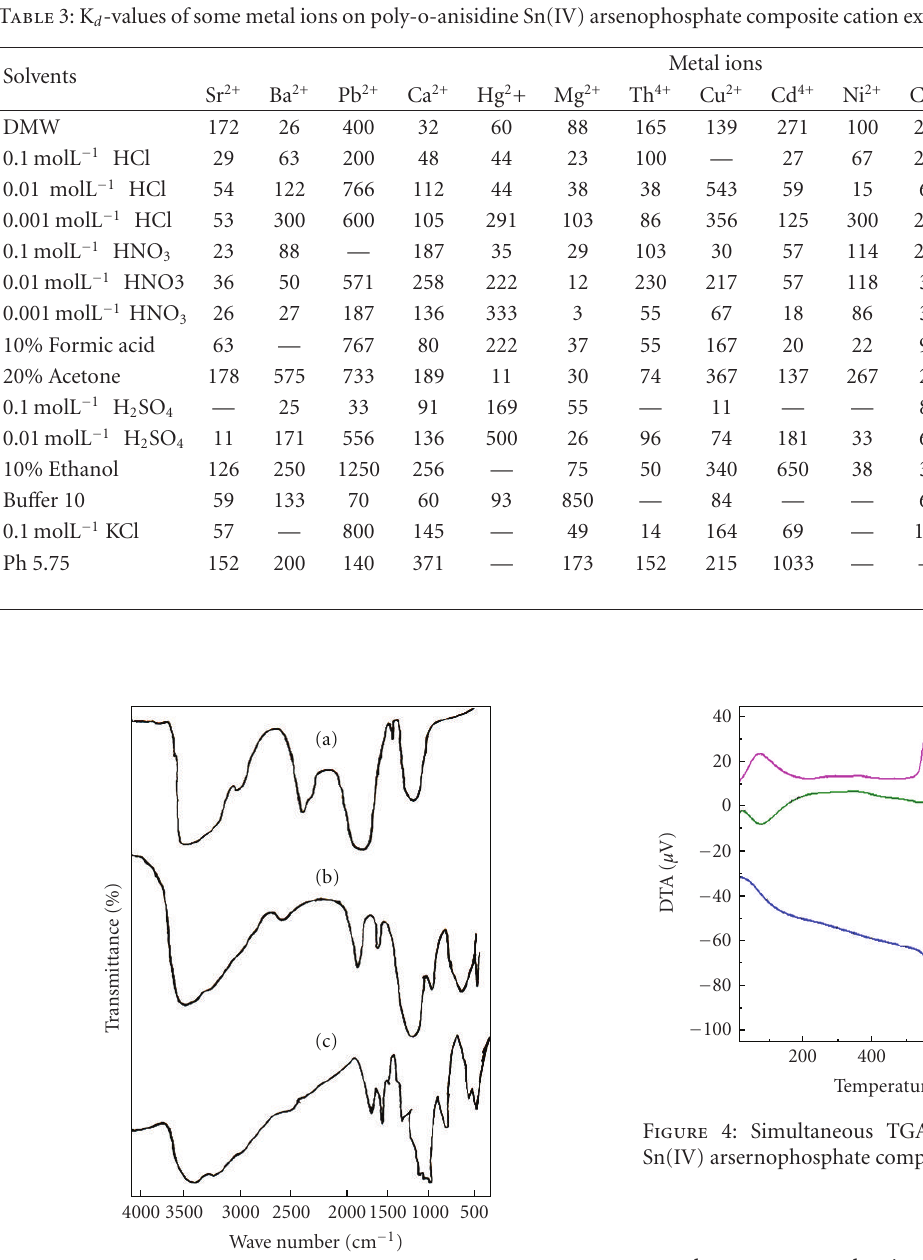
Figure 3: FTIR spectra of poly-o-anisidine (a) Sn(IV) arsenophos- phate (b) and poly-o-anisidine Sn(IV) arsenophosphate composite cation exchanger (c).